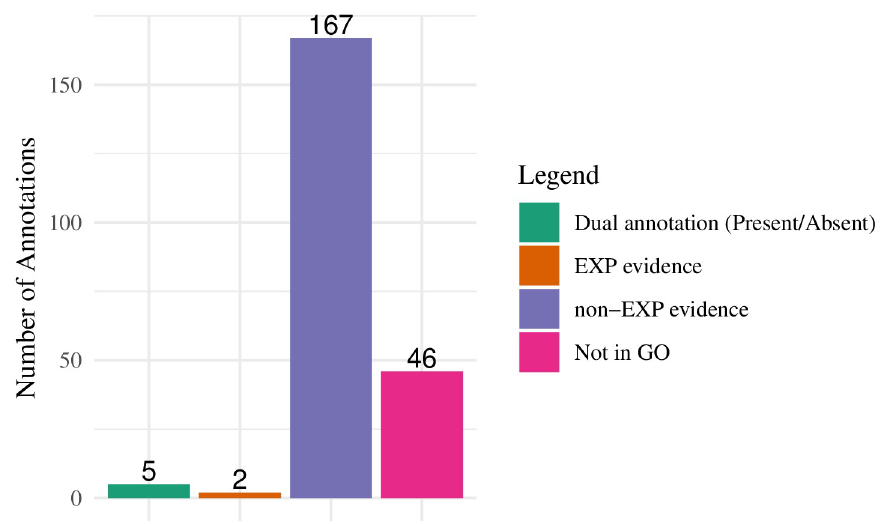
Fig 9. Comparison of our 220 proposed annotations to annotations currently in the GO database. Of the 220, 46 were not found in the GO database, 8 of which we proposed as negative assertions. Of the remaining 174 which we found in the GO database, five were inconsistent (having both a present and absent annotation), two had an experimental evidence code, and the remainder, 167, corresponded to annotations without experimental evidence.